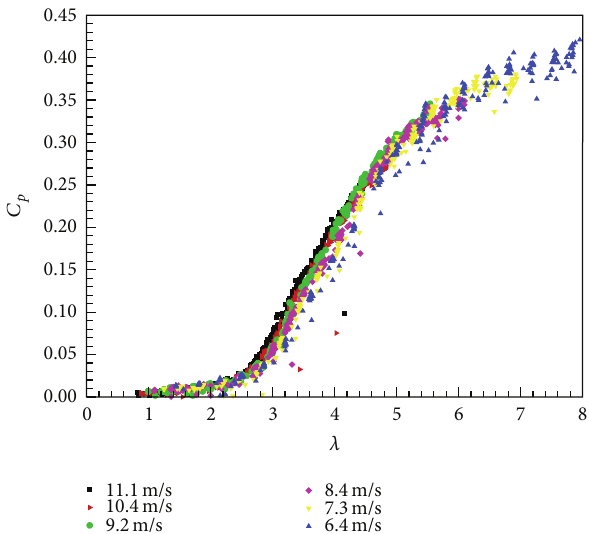
Figure 8: Raw experimental 𝐶 𝑝 versus 𝜆 results for a 𝑈 ∞ range of 6.4 m/s to 11.1m/s [1].